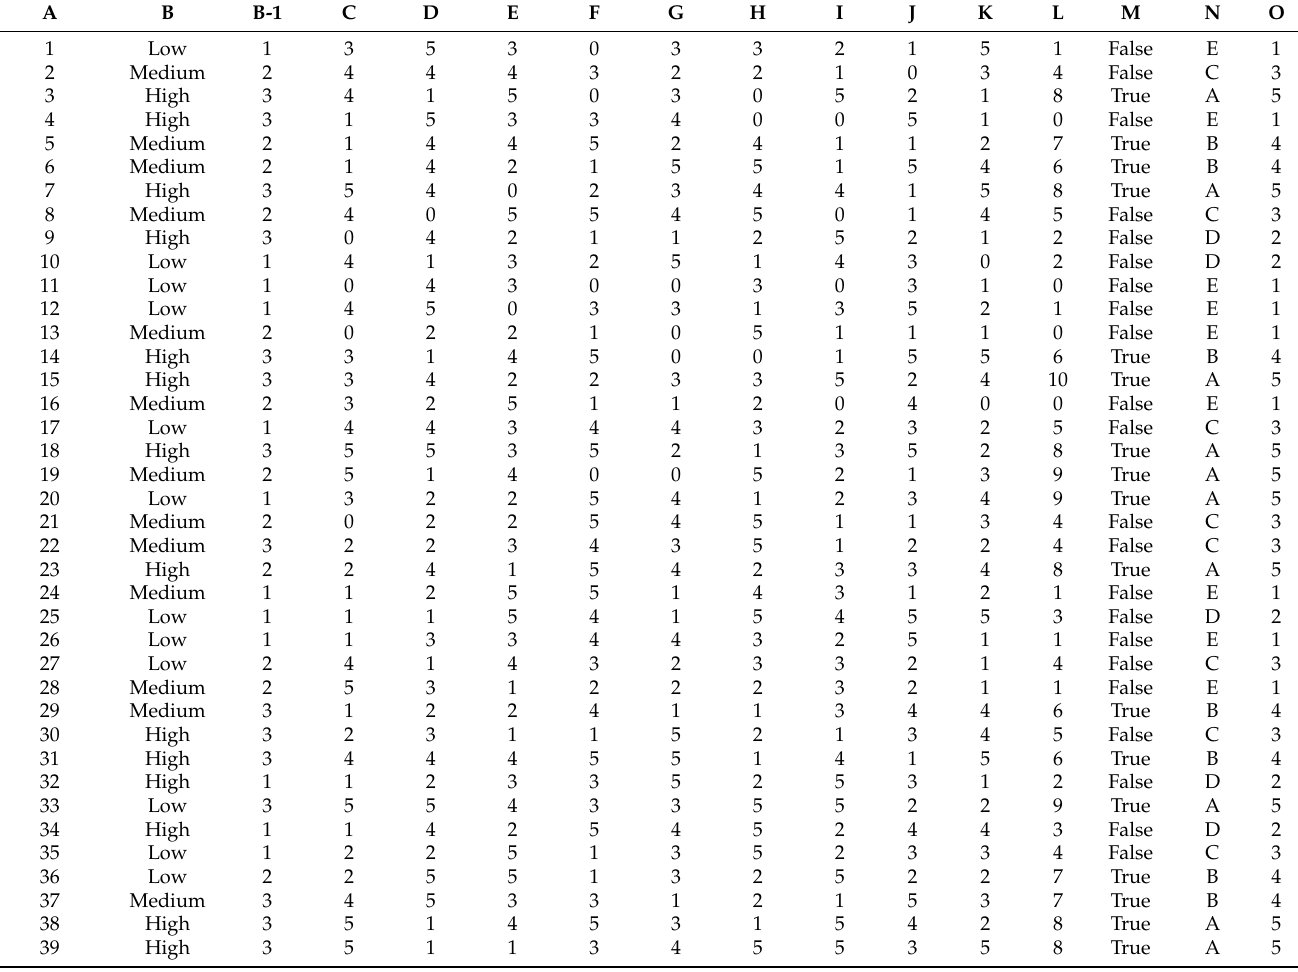
Table 2. Data table with the correlation between independent variables and the dependent